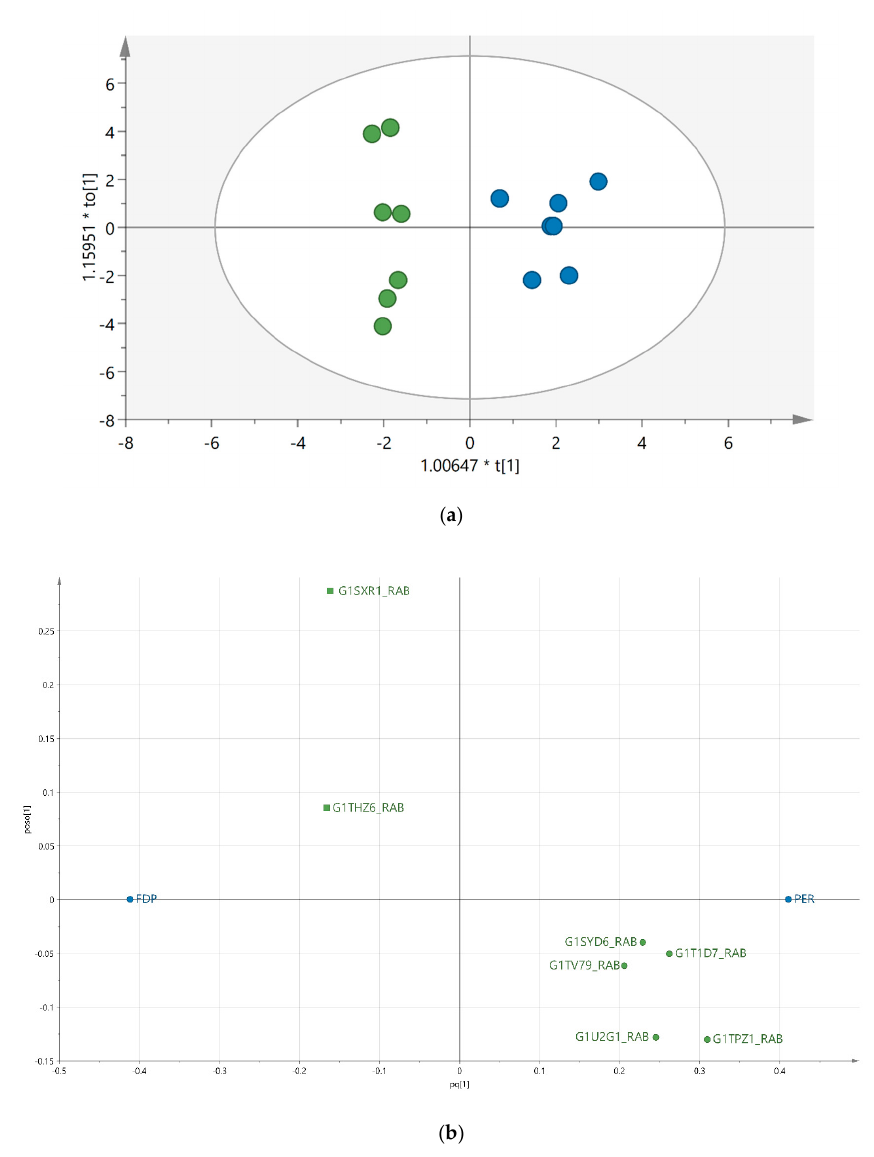
Figure 2. ( a ) An OPLS-DA (orthogonal partial least square discriminant analysis) model showing the discriminant separation between FDP (green filled circles and PER (blue filled circles). The longitudinal dimension ( Y -axis) shows the interclass discrimination, and the latitudinal dimension ( X -axis) shows the intraclass discrimination between the groups. ( b ) Loading plot corresponding to significant proteins, with a variable of importance (VIP) value > 1 important for FDP (square) and PER (circle). G1TPZ1_RABIT (Galectin), G1T1D7_RABIT (Periostin), G1U2G1_RABIT (Histone H2A), G1SYD6_RABIT (Lamin-A / C), G1TV79_RABIT (SerpinH1), G1SXR1_RABIT (Prolargin), G1THZ6_RABIT (Ig gamma chain C